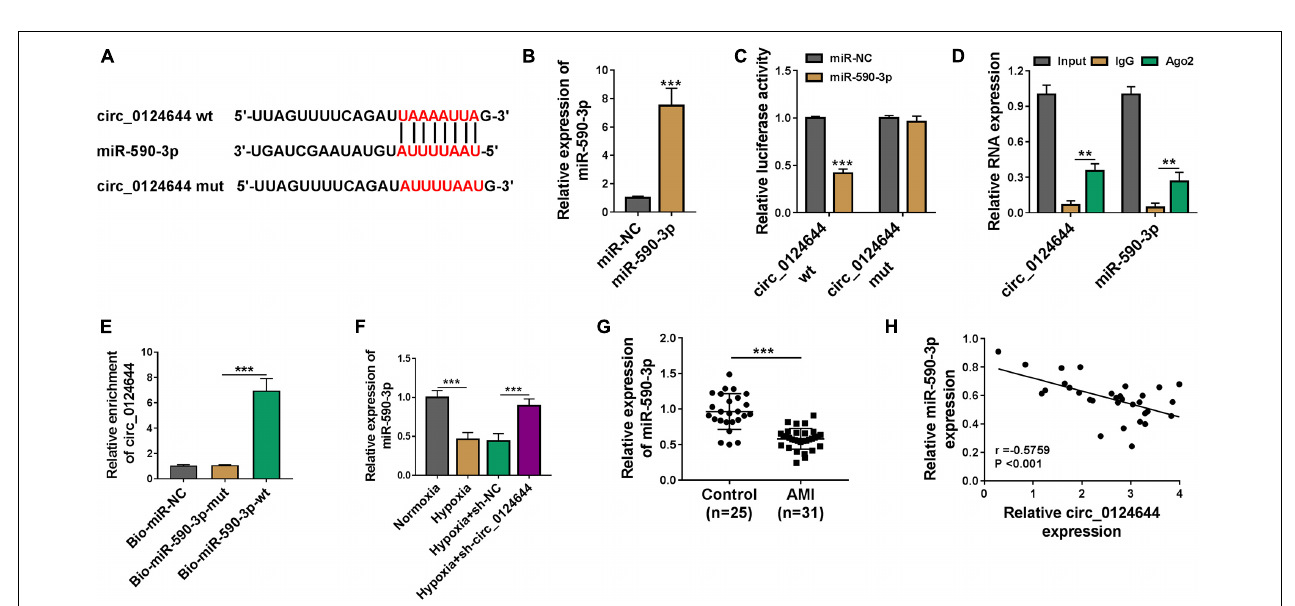
FIGURE 3 | Circ_0124644 acted as a sponge of miR-590-3p. (A) The predicted and mutated binding sites between miR-590-3p and circ_0124644 were exhibited. (B) The transfection efficiency of miR-590-3p mimic was confirmed by detecting miR-590-3p expression in AC16 cells using qRT-PCR. Dual-luciferase reporter assay (C) , RIP assay (D) , and RNA pull-down assay (E) were employed to assess the interaction between miR-590-3p and circ_0124644. (F) AC16 cells were transfected with sh-NC or sh-circ_0124644, followed by treated with hypoxia. AC16 cells treated with normoxia were used as control. The expression of miR-590-3p was examined by qRT-PCR. (G) The expression of miR-590-3p in the serum of AMI patients and healthy control volunteers was determined by qRT-PCR. (H) Pearson correlation analysis was used to assess the correlation between miR-590-3p and circ_0124644. ** P < 0.01, *** P < 0.001.